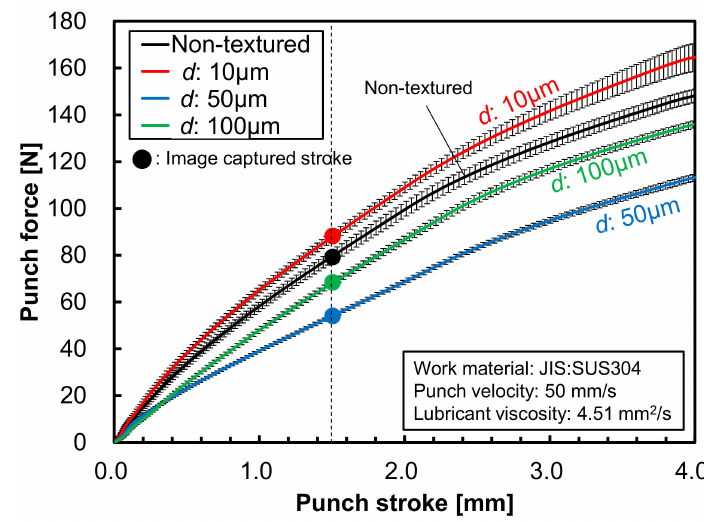
Figure 7. Punch force–stroke curves of bending with the ironing process using the non-textured die and surface textured die with di ff erent dimple diameters of 10 µ m, 50 µ m, and 100 µ m.